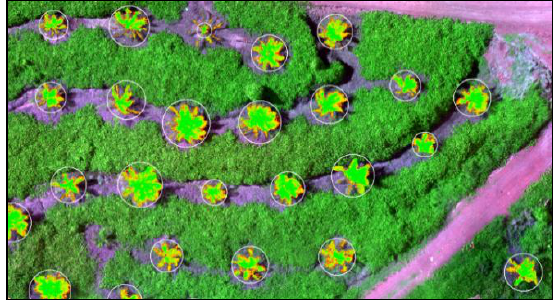
Figure 4. Individual oil palm crown NDVI